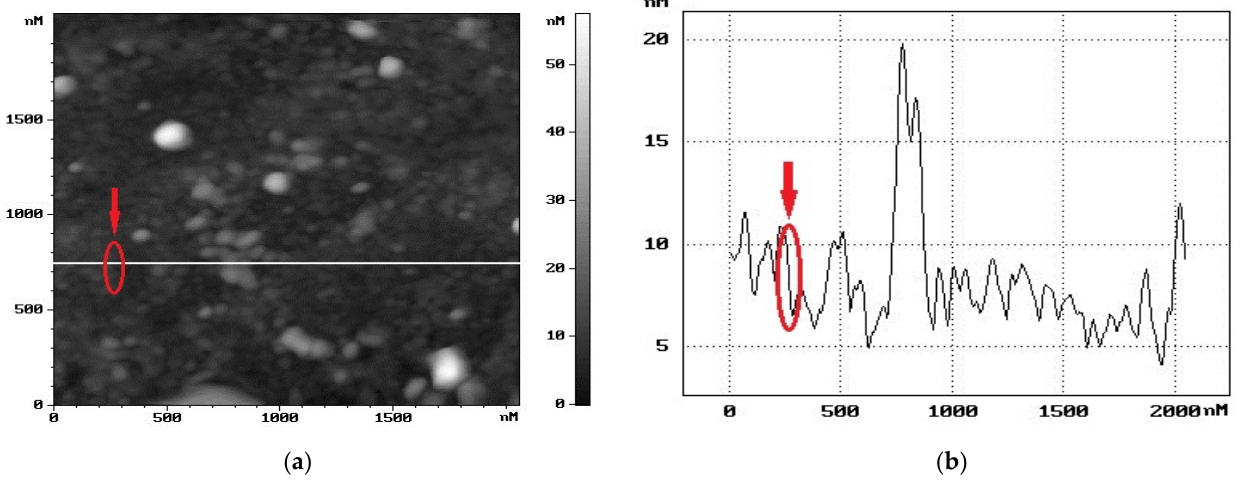
Figure 12. Topography of the graphene surface of a chip from Group 1 after graphene functionalization and immobilization of influenza B virus antibodies. ( a ) AFM image of the surface. ( b ) AFM profile of the graphene surface along the white line in ( a ). The peak in the graph reveals an aggregate on the graphene surface up to a 20-nm height. The arrow denotes a step on the graphene surface.